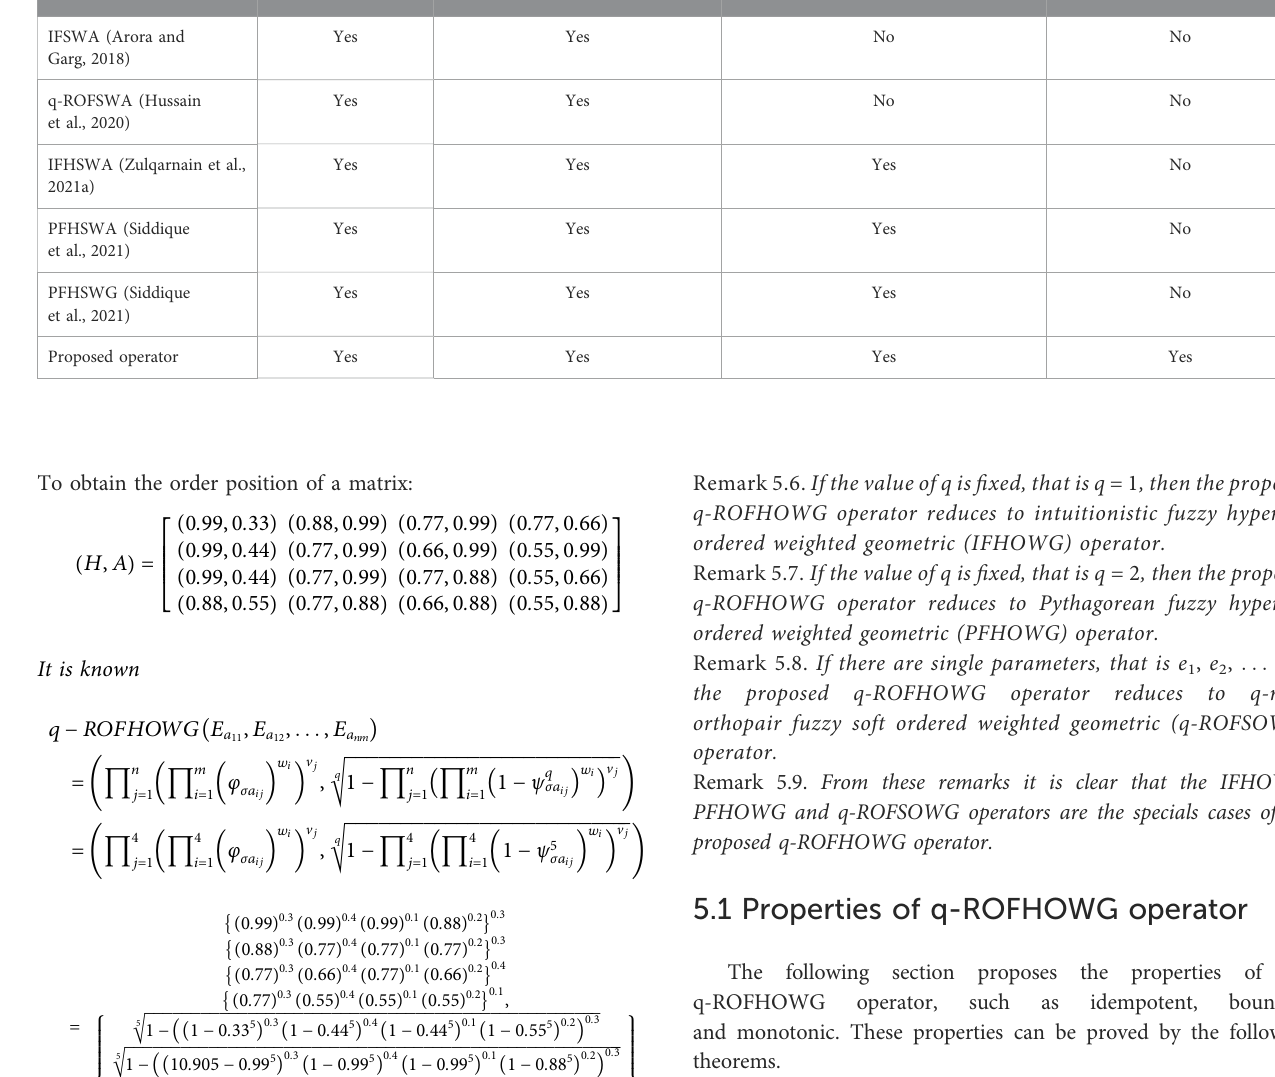
TABLE 1 Comparison of q-ROFHSs operators with some existing operators. Fuzzy